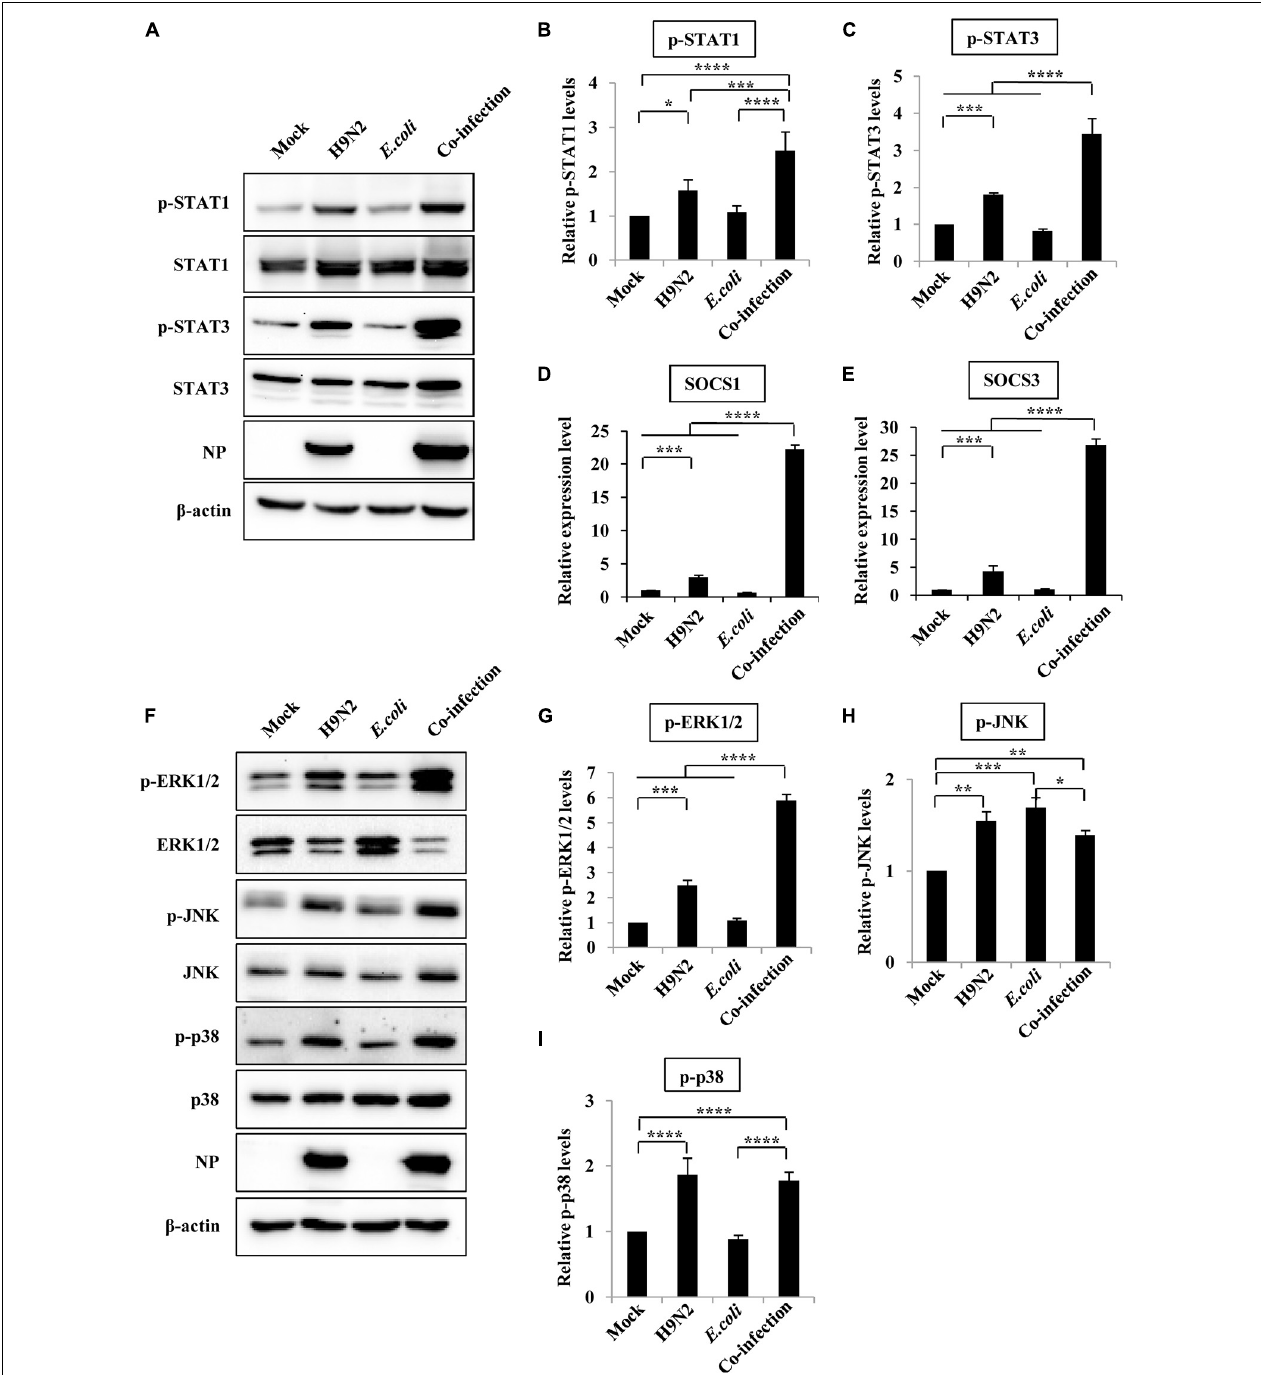
FIGURE 5 | JAK/STAT/SOCS pathway and MAPK pathway are involved in aberrant expression of cytokines after viral-bacterial co-infection. Four groups of BALB/c mice were mock infected, or intranasally infected with single H9N2 AIV (1 × 10 4 PFU) and E. coli (1.5 × 10 7 CFU), or co-infected with H9N2 and E. coli for 48 h. Then the mice were euthanized, and the lungs were ground for the preparation of protein and RNA samples. (A) Protein samples were analyzed by western blotting with the indicated antibodies. Shown are representative data of three independent experiments with similar results. (B,C) Levels of p-STAT1 (B) and p-STAT3 (C) in (A) were quantitated by densitometry, and normalized to their total protein and β -actin levels. Plotted are the average levels from three independent experiments. The error bars represent the SE. (D,E) Quantitative real-time PCR was used for detecting the expression of SOCS1 (D) and SOCS3 (E) in mice lungs. (F) Western blotting was used to determine the phosphorylation level of ERK1/2, JNK, and p38 in mice lungs. The results are representative of three independent experiments. (G–I) Levels of p-ERK1/2 (G) , p-JNK (H) and p-p38 (I) in (F) were quantitated by densitometry, and normalized to their total protein and β -actin levels. Plotted are the average levels from three independent experiments. The error bars represent the SE. * P < 0.05, ** P < 0.01, *** P < 0.001, **** P < 0.0001.